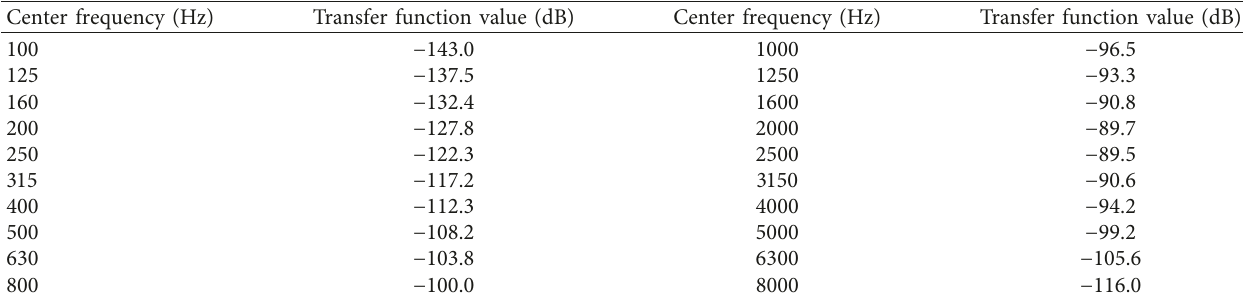
Table 3: Empirical parameters of engine body structure